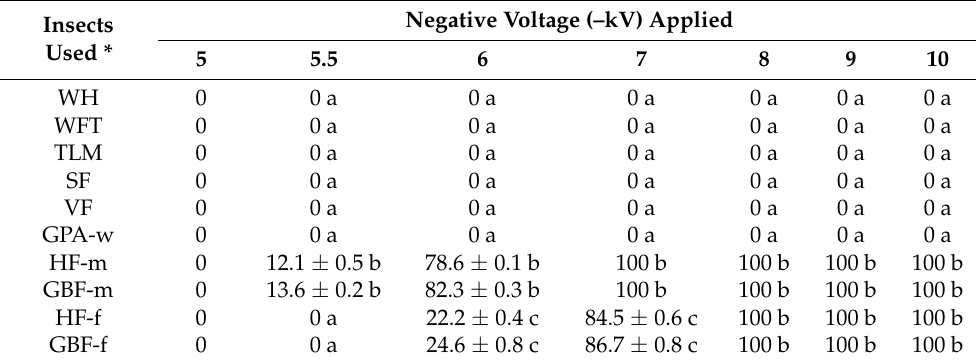
Table 2. Capture of insects with different body sizes by an experimental instrument consisting of a negatively charged insulated conductor (iron) plate (NIP) and a grounded non-insulated conductor plate (GCP) at a separation interval of 10 mm. Negative Voltage (–kV) Insects Used *